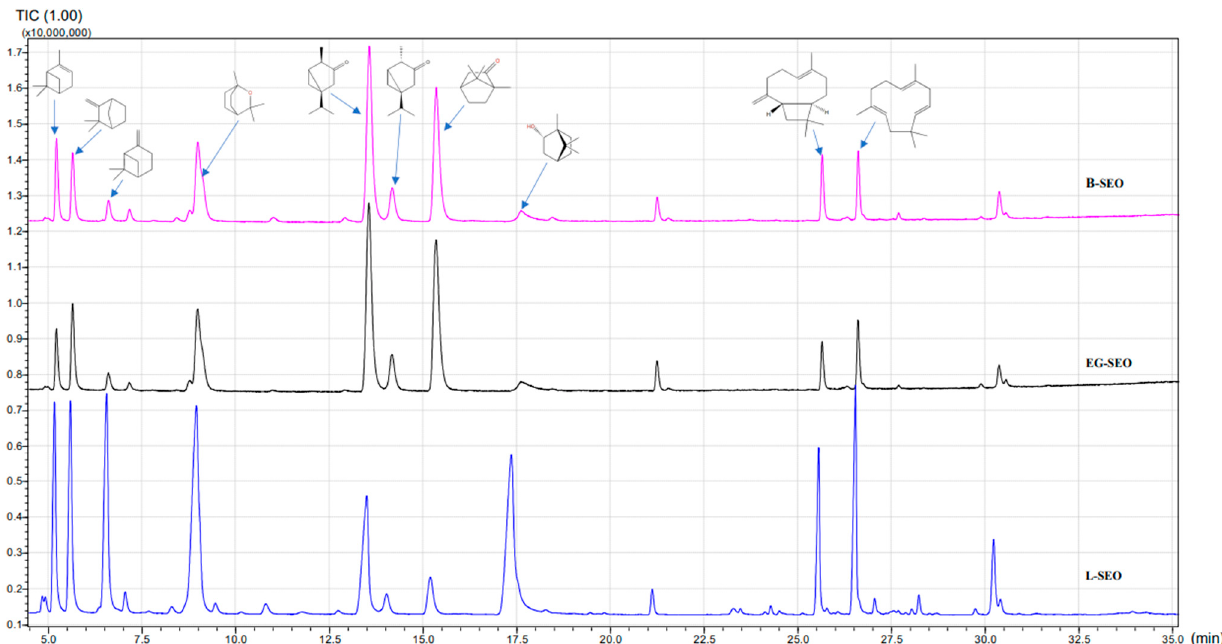
Figure 1. GC-MS chromatograms obtained for the investigated Salvia officinalis essential oil samples: B-SEO, pink; EG-SEO, black; L-SEO,